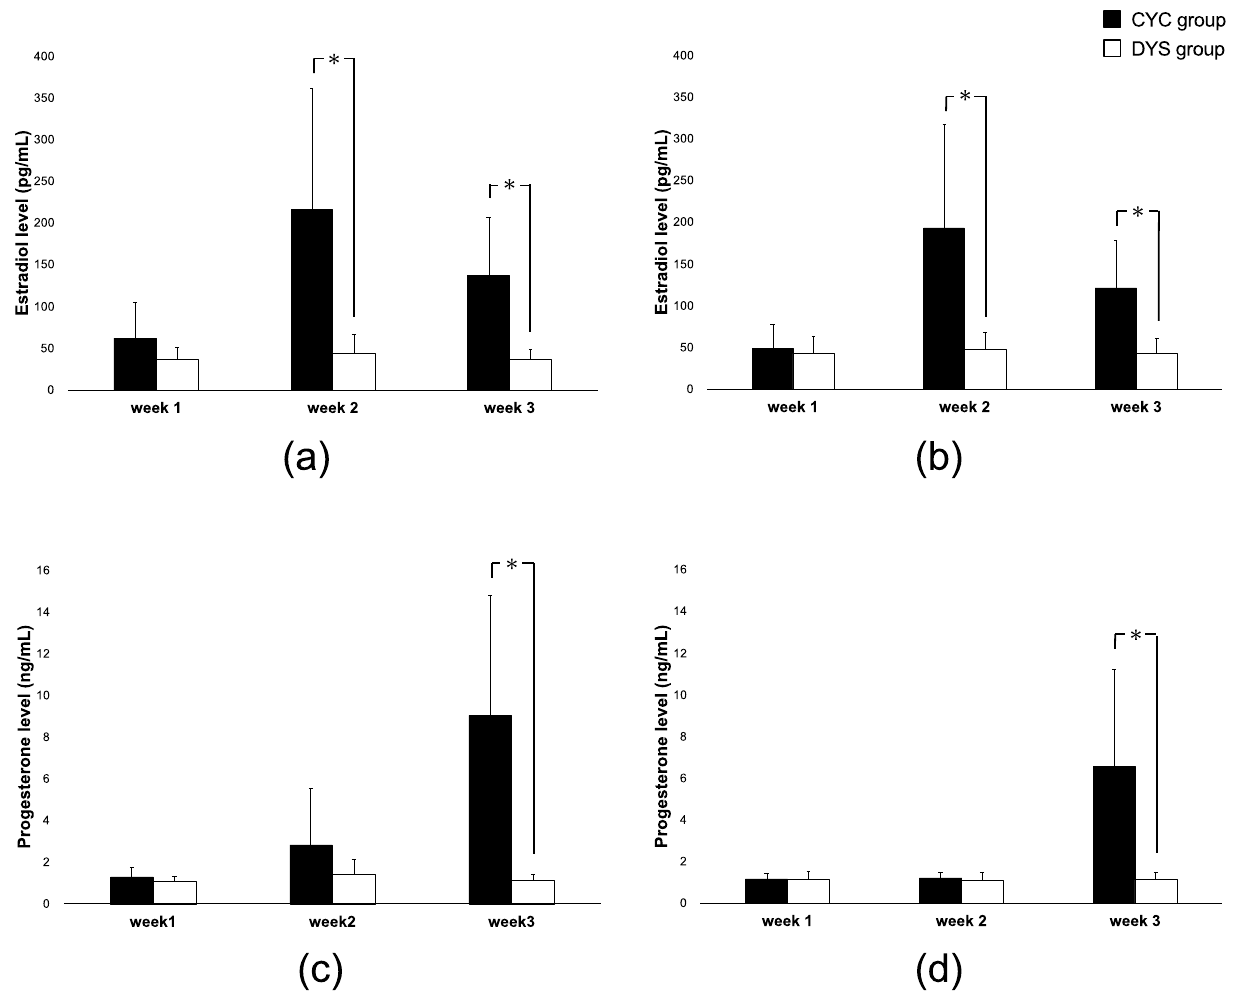
Figure 1. Ovarian hormone levels over all weeks. ( a ) Estradiol concentration by group under exercise conditions, ( b ) estradiol concentration by group under rest conditions, ( c ) progesterone concentration by group under exercise conditions, and ( d ) progesterone concentration by group under rest conditions. The cycling (CYC) group is represented by black bars. The irregular menstrual cycle (DYS) group is represented by white bars. Error bars represent SD. * indicates p < 0.05 between CYC and DYS group in each condition.